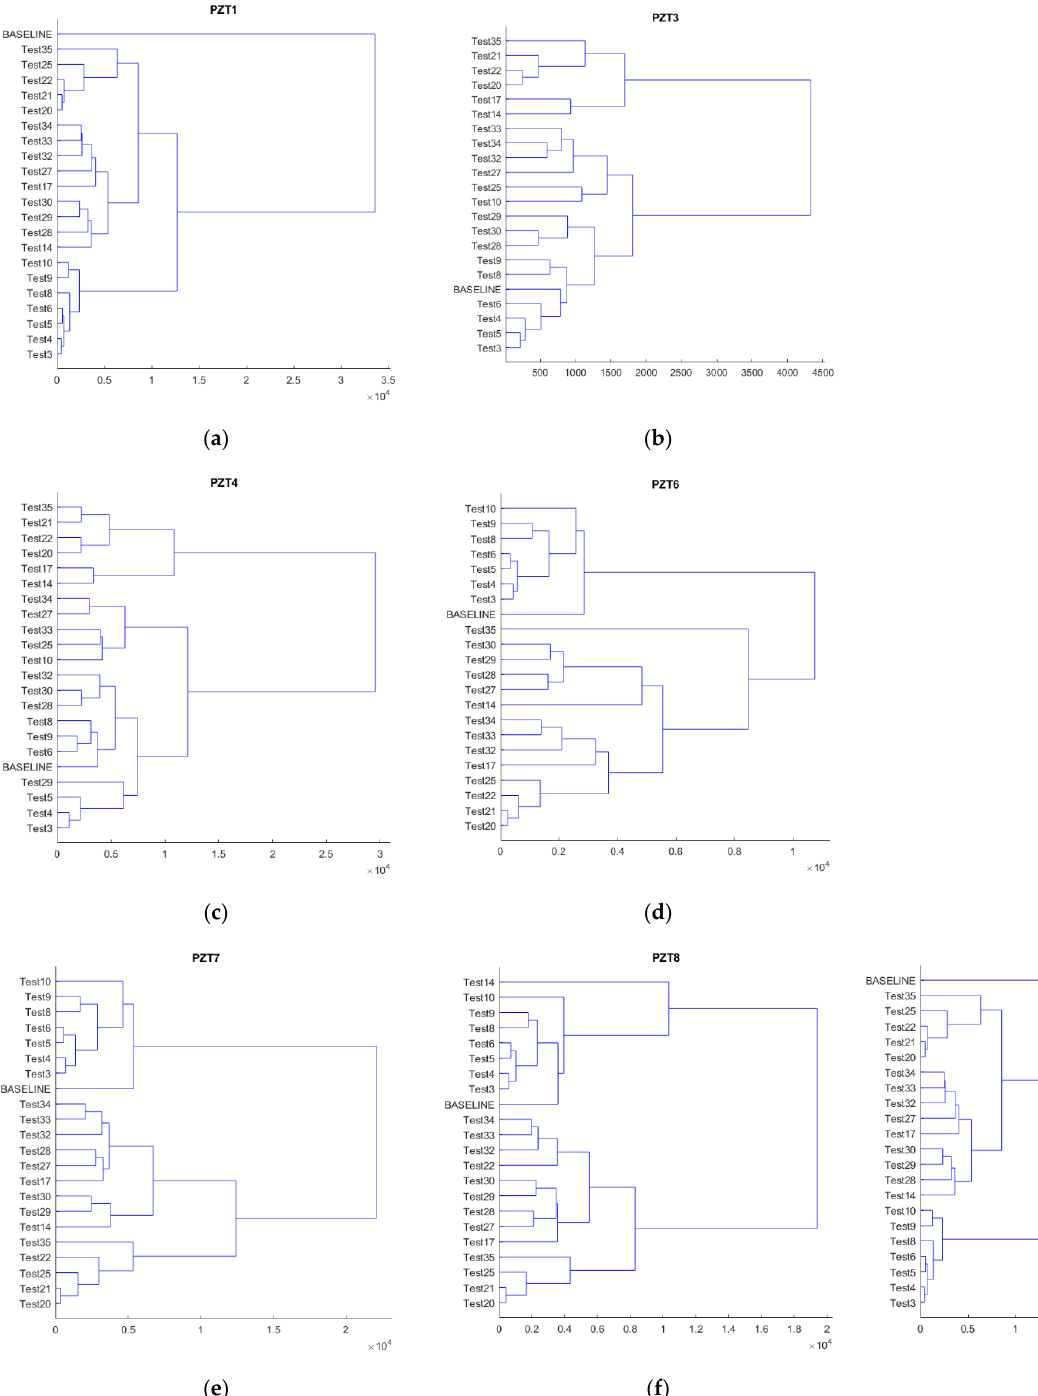
Figure 8. Hierarchical trees considering only tests subjected to load. ( a ) PZT1, ( b ) PZT3, ( c ) PZT4, ( d ) PZT6, ( e ) PZT7, ( f ) PZT8, ( g ) PZT9 .